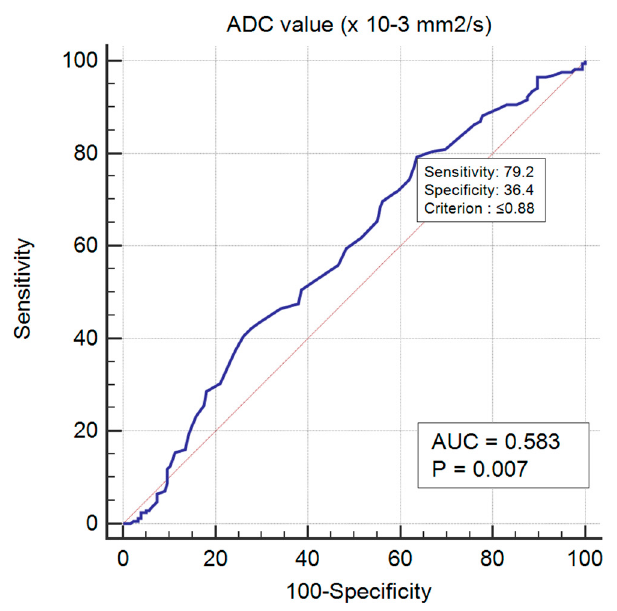
Figure 6. ROC curve for predicting luminal B HER2 negative Figure 7. ROC curve for predicting luminal B HER2 negative BC. Figure 7. ROC curve for predicting luminal B HER2 negative BC.